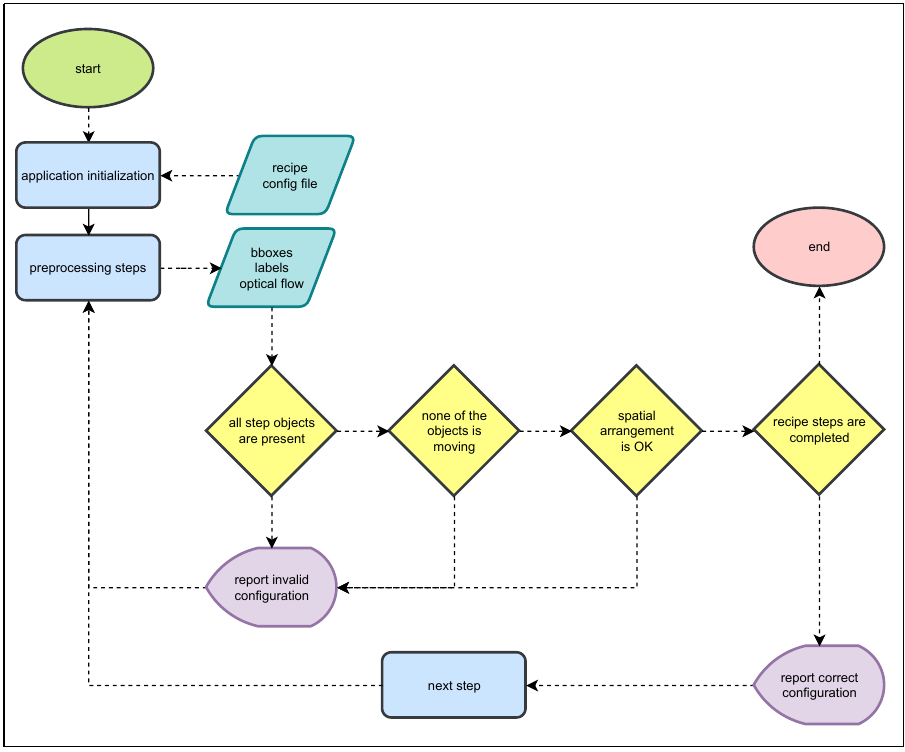
Figure 10. Workflow of our